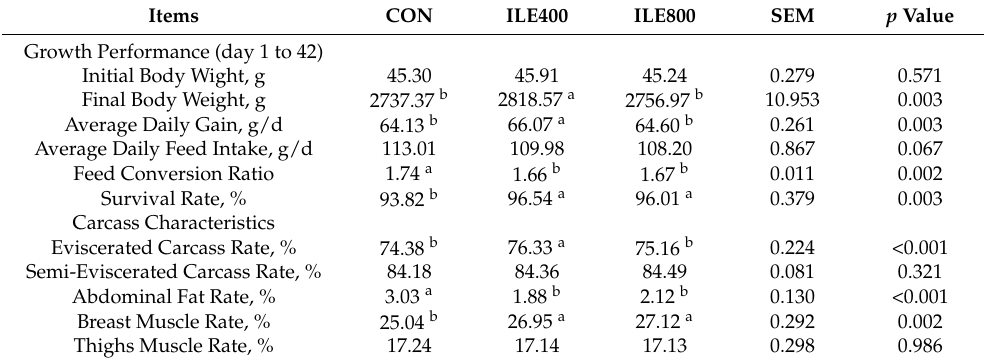
Table 3. The effect of dietary supplementation with isoleucine (Ile) on broiler production performance. Items CON ILE400 ILE800 SEM p